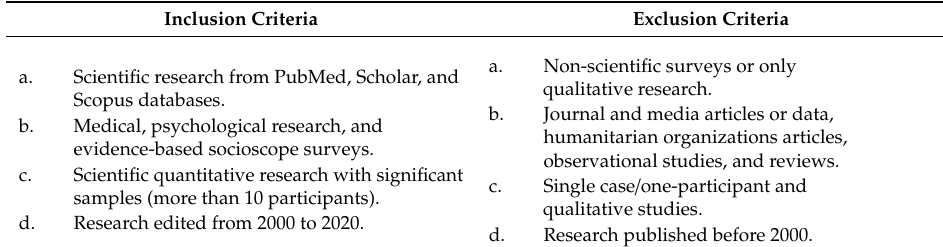
Table 2. Inclusion and exclusion criteria.